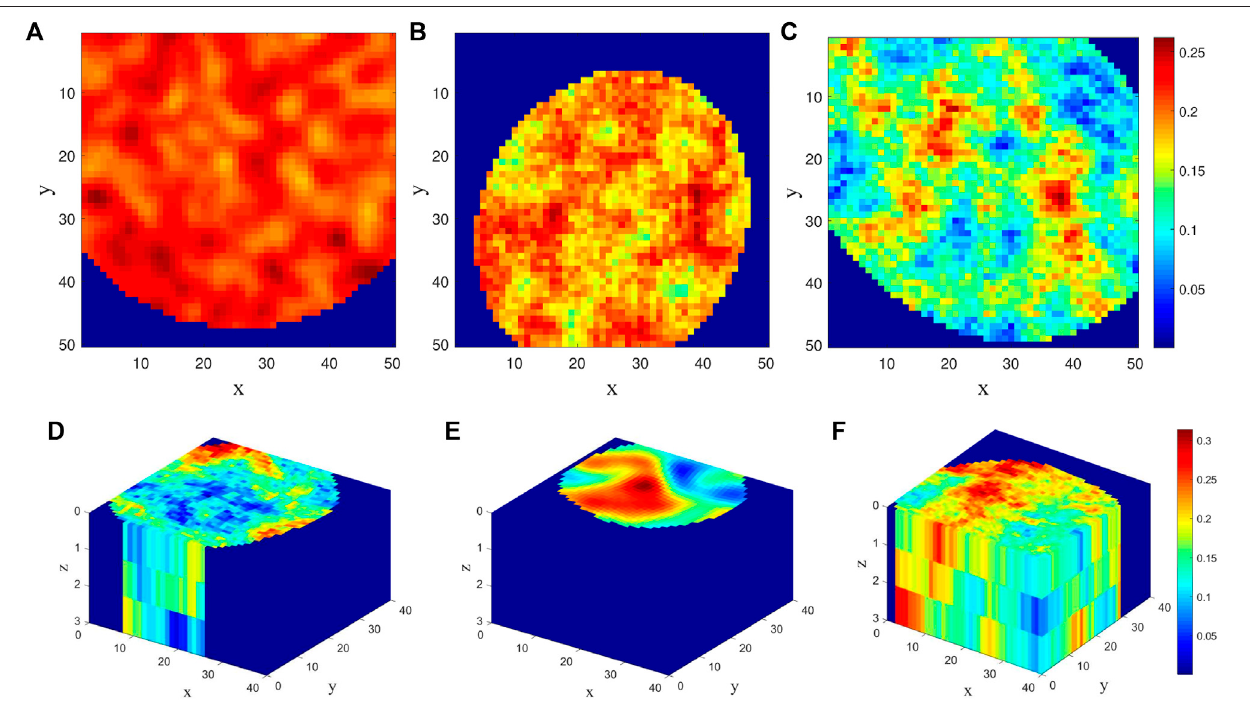
FIGURE 3 | Porosity fi elds for random training scenarios of the 2D and 3D models sampled from the parameter distributions given in Table 1 .